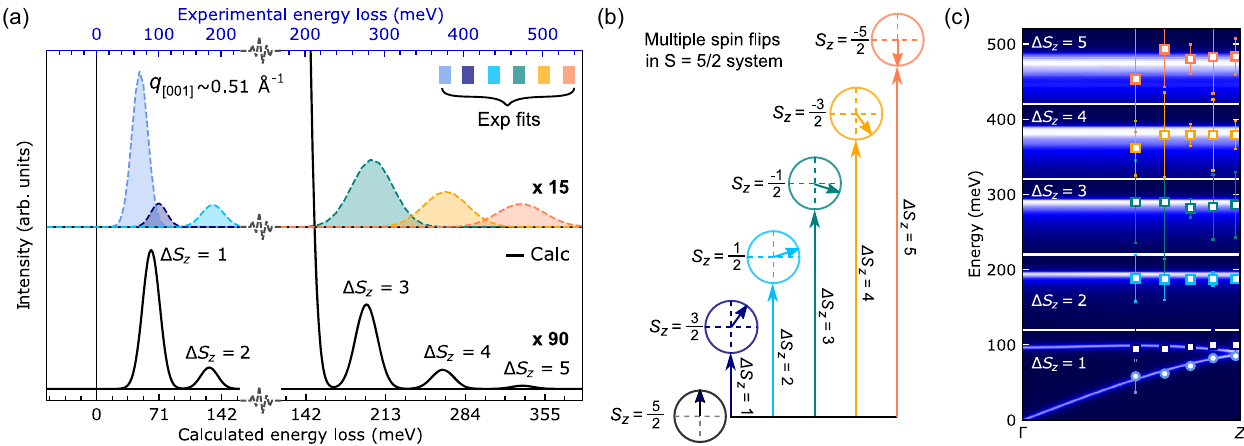
FIG. 3. Calculations of magnetic excitations for α -Fe 2 O 3 . (a) Calculated RIXS spectrum of multispin-flip excitations using the LDA þ DMFT AIM (black solid line). The color-filled Gaussians are the fitting results of the experimental RIXS data in Fig. 2(a). The elastic peak is removed in both spectra. The calculated spectral weight for Δ S possible arguments are presented in Sec. VI of Ref. [40]. (b) A diagram of the possible multispin-flip excitations for an S ¼ 5 using a local picture. (c) The q -resolved DOS of the AFM magnons. The single-magnon is calculated within the Heisenberg model. The multimagnons are obtained as a convolution of multiple single magnons, as explained in the text. For each Δ S normalized to the maximum achieved in the investigated q range. The horizontal white lines define the energy windows used for each DOS normalization. The markers are the experimental RIXS energies identified in Fig. 2(c) for the acoustic (circles) and optical (squares)